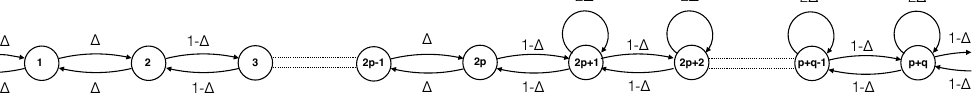
Figure 12 . Parameterization of the R-charges for the L pqp (necklace) theories. A label over an arrow denotes the R-charge (in terms of ∆ ) of the corresponding matter field.